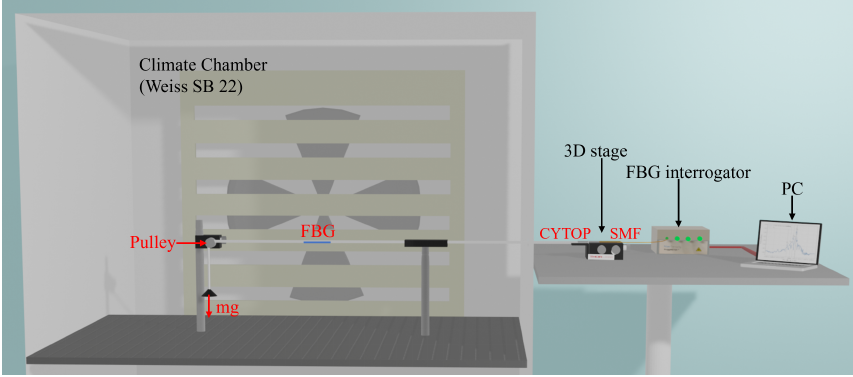
Figure 3. The experimental setup of CYTOP-FBG response to temperature, humidity and